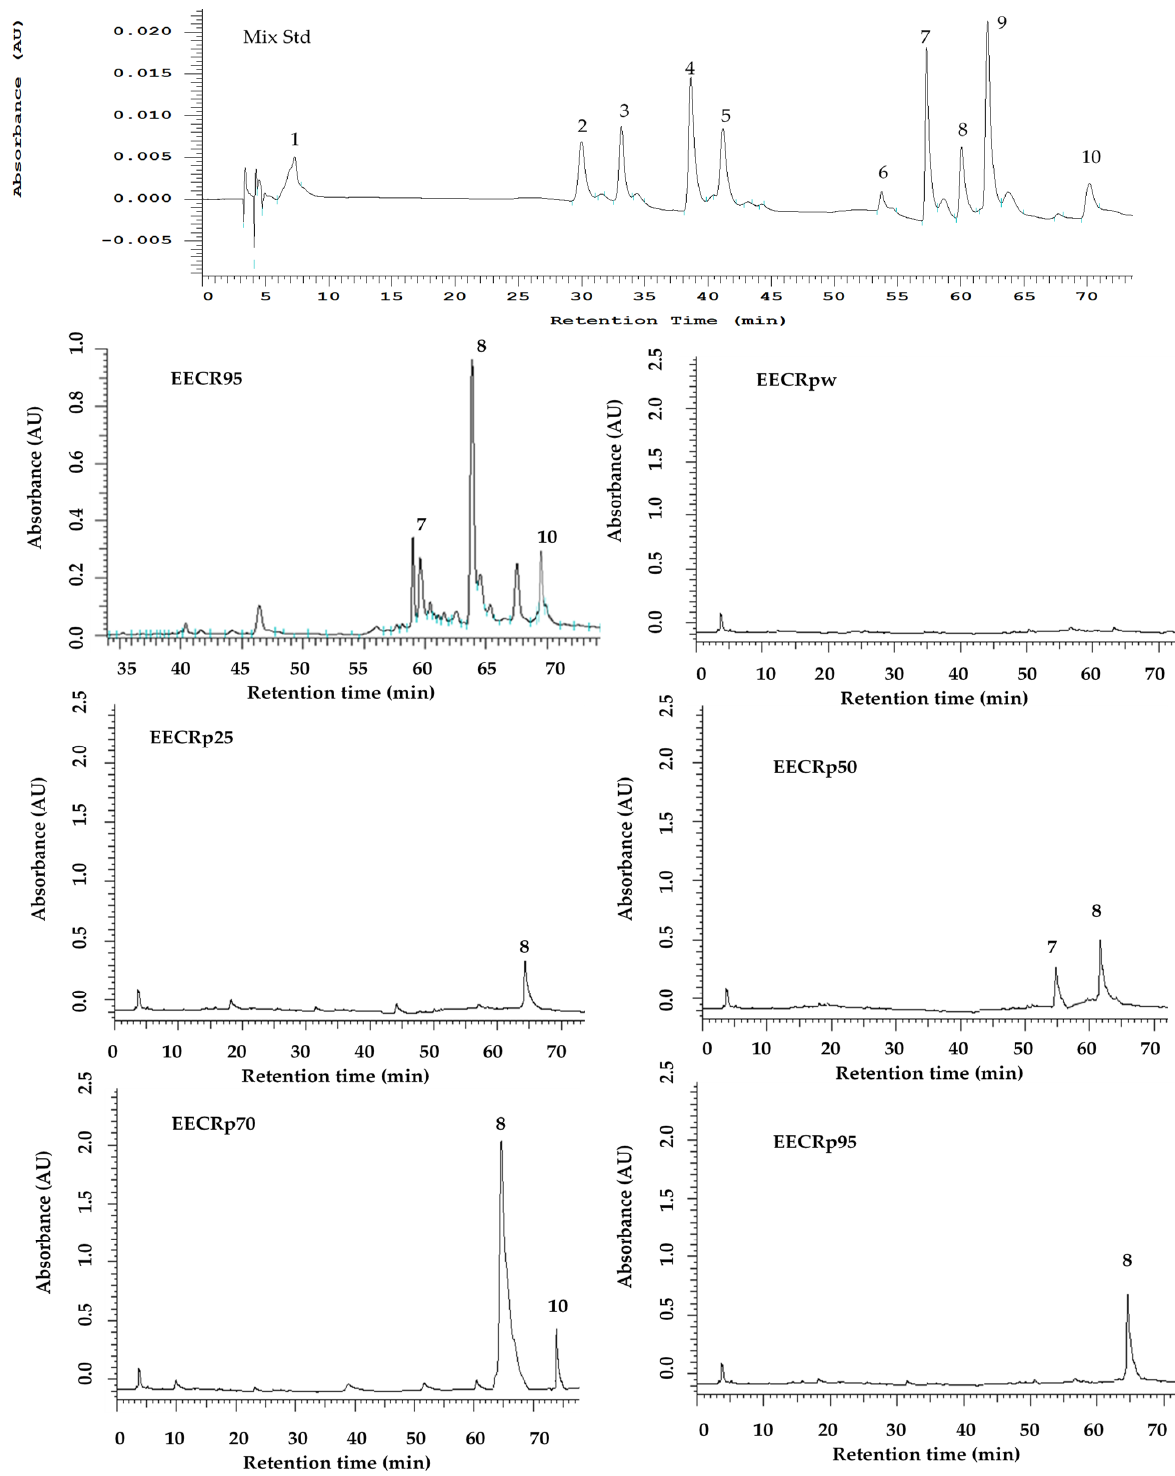
Figure 2. High performance liquid chromatography chromatograms of flavonoids composition of EECR95 (95% ethanol extract from C. cajan (L) Millsp. roots), EECRpw (water eluent of EECR95) and EECRp25-p95 (25–95% ethanol eluent of EECR95). Peaks 1–10 are as follows: (1) gallic acid; (2) Vannilic acid; (3) Syringic acid; (4) Courmaric acid; (5) Ferullic acid; (6) Rutin; (7) daidzein (8) genistein; (9) quercetin; and (10) cajanol.